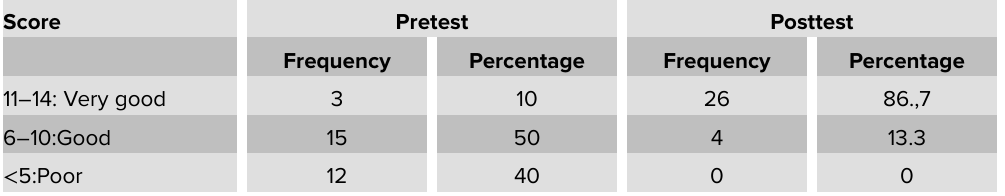
TABLE 4: Improvement in knowledge among participants( n